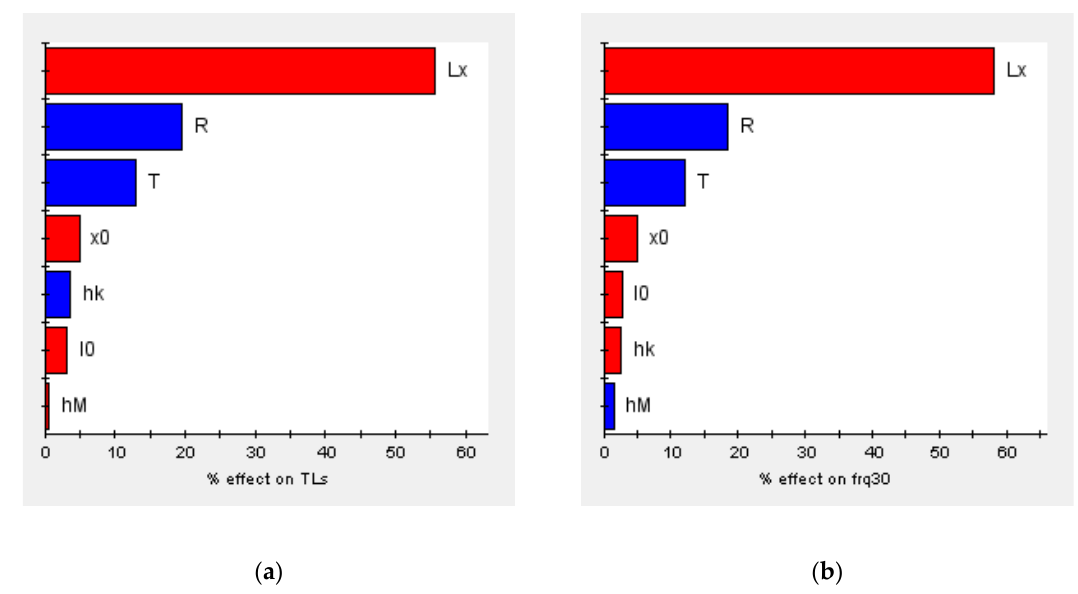
Figure 13. Pareto graphs of the optimization objectives: ( a ) TLs and ( b ) frq 30 .